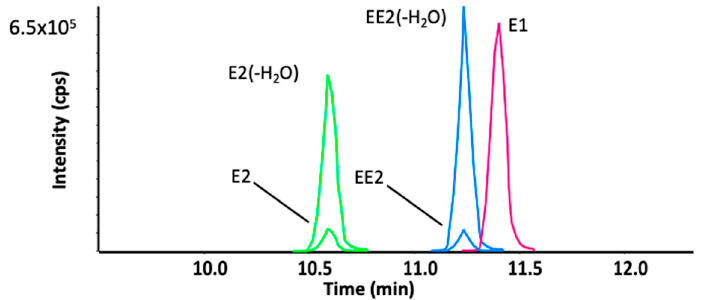
Figure 2. Extracted ion chromatograms for protonated E1, E2 and EE2 from control incubations (at 10 µ M). Both E2 and EE2 exhibit a facile water loss in the electrospray source.